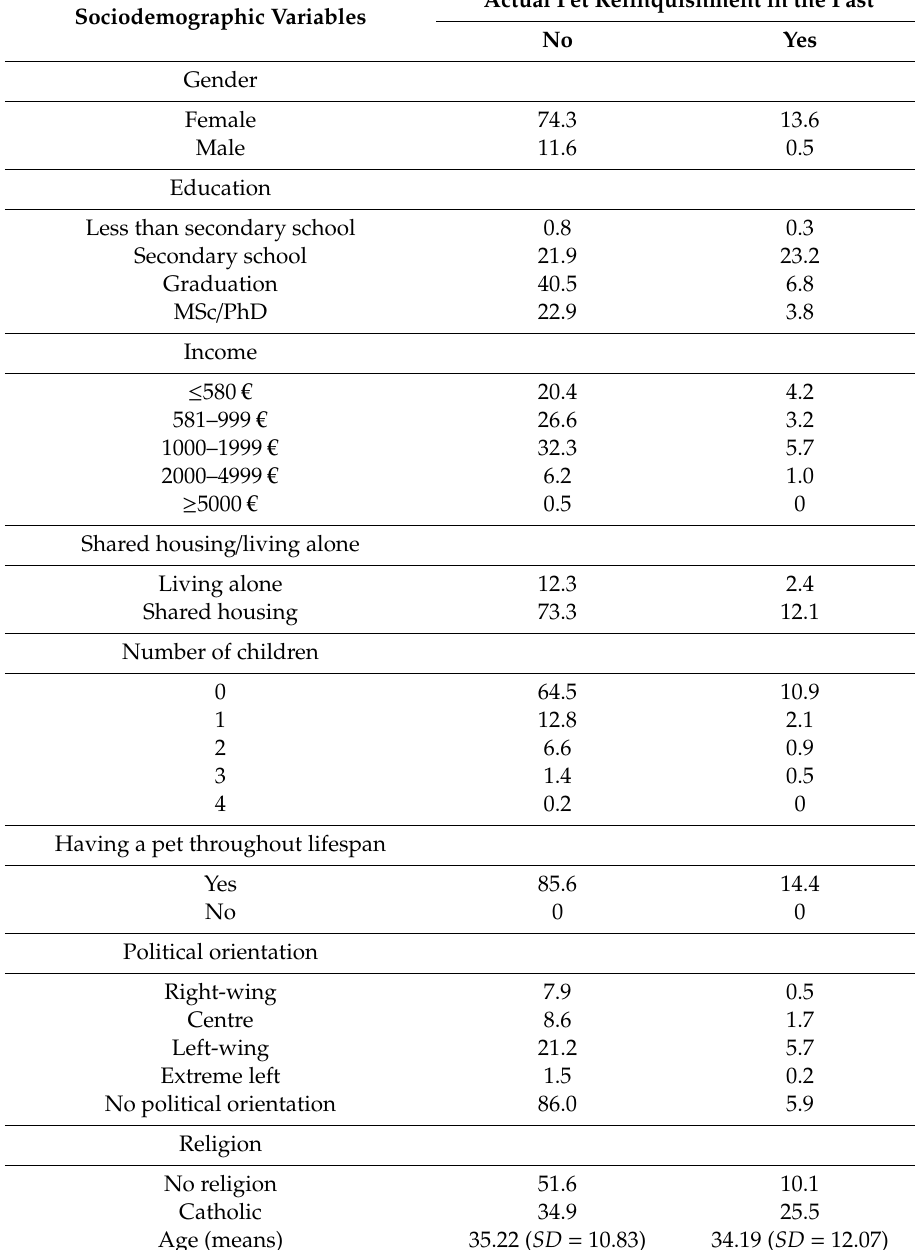
Table1. Actualpetrelinquishmentinthepastbyparticipants’demographics(inpercentagesandmeans). Sociodemographic